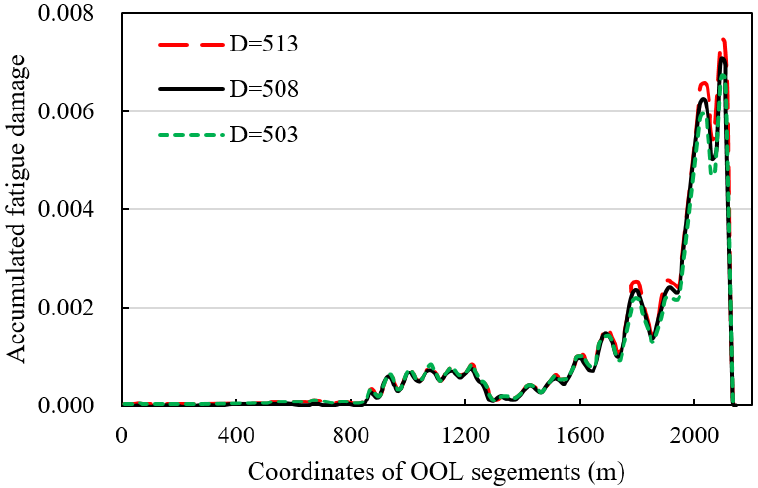
Figure 16. Fatigue damage of OOL with different outer